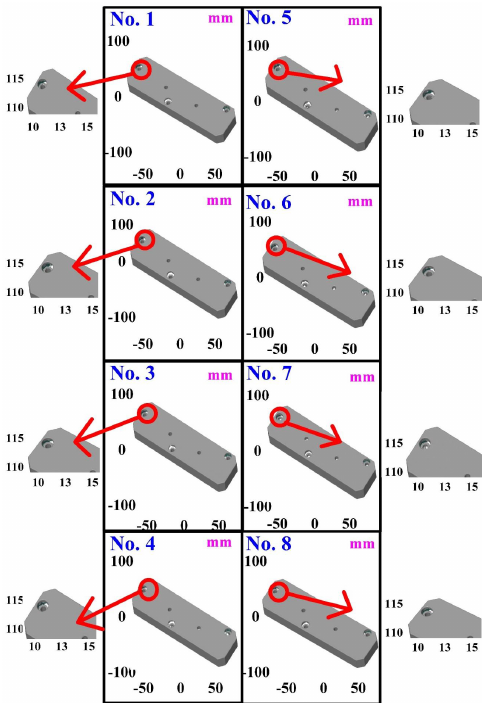
Figure 9. Measurement results of the cast part after CNC machining that was not sprayed with a mixture of ethanol and TiO 2 powder.